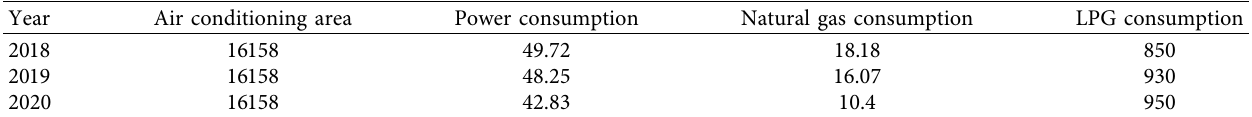
Table 2: Annual building energy consumption.